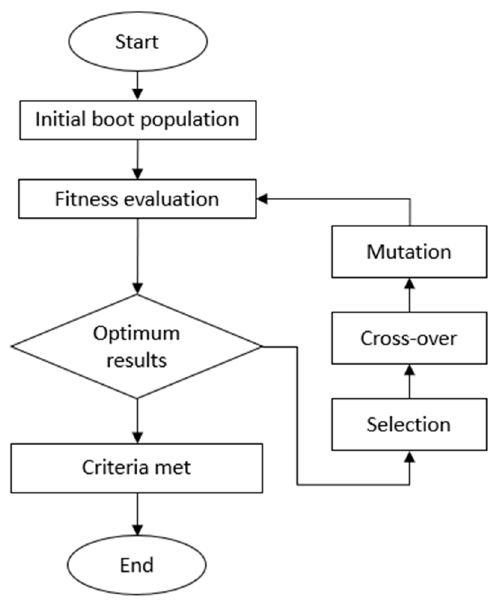
Figure 3. The artificial bee colony algorithm (ABC) process, as adapted from Ref. [40].